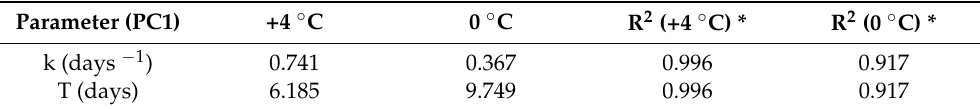
Table 2 . Kinetic parameters estimated from exponential models for N-TMA concentrations and K- Index values in red mullets ( Mullus barbatus ) at +4 °C and 0 °C.